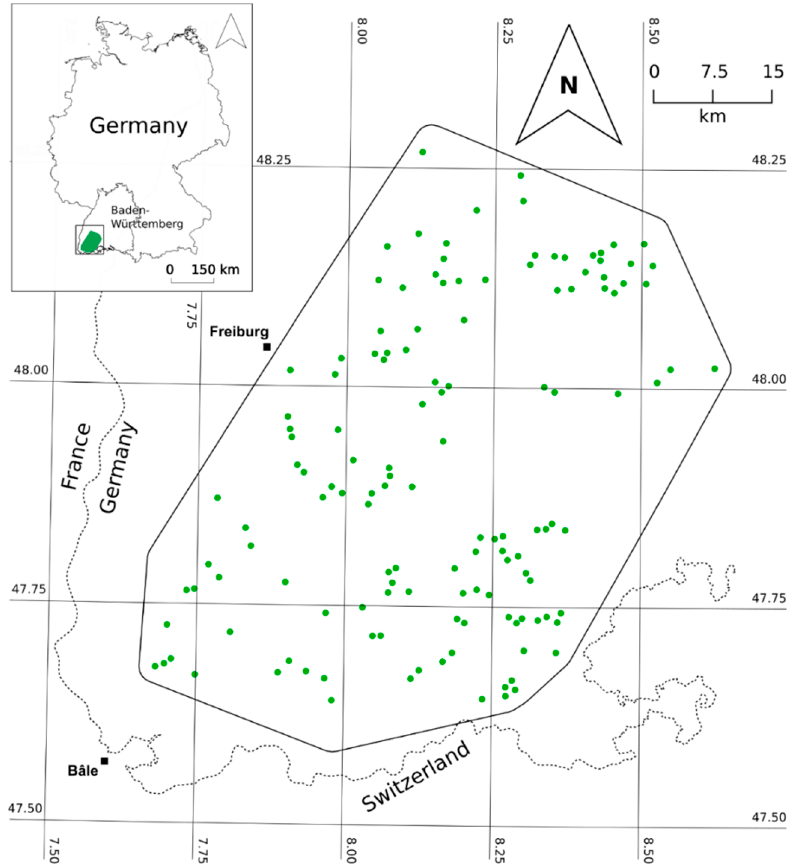
Figure 1. Map of the ConFoBi research area with research plots marked as green circles. The dotted line indicates the border of the state of Baden-Württemberg to France and Switzerland.